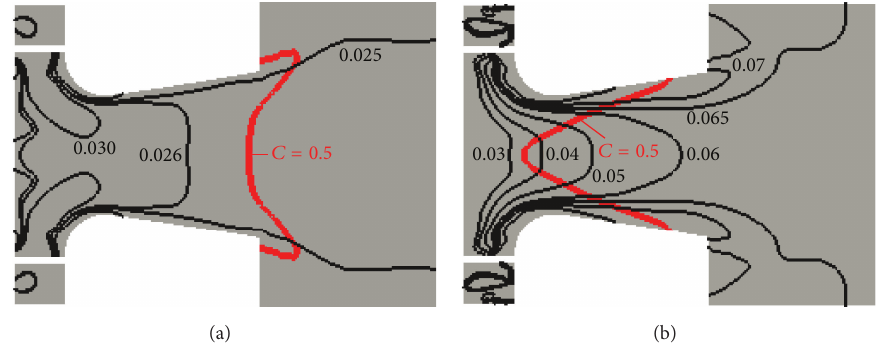
̃𝐶 = 0.5) for (a) NG-FGR0